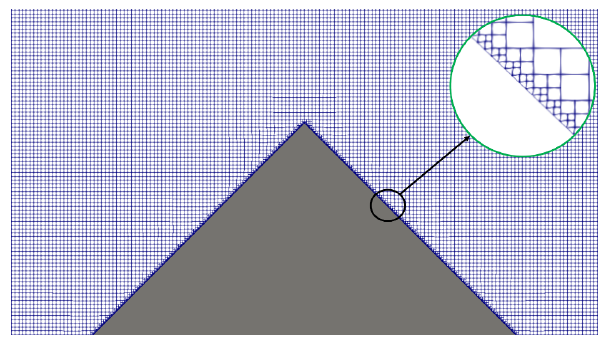
Figure 10. Schematic of the